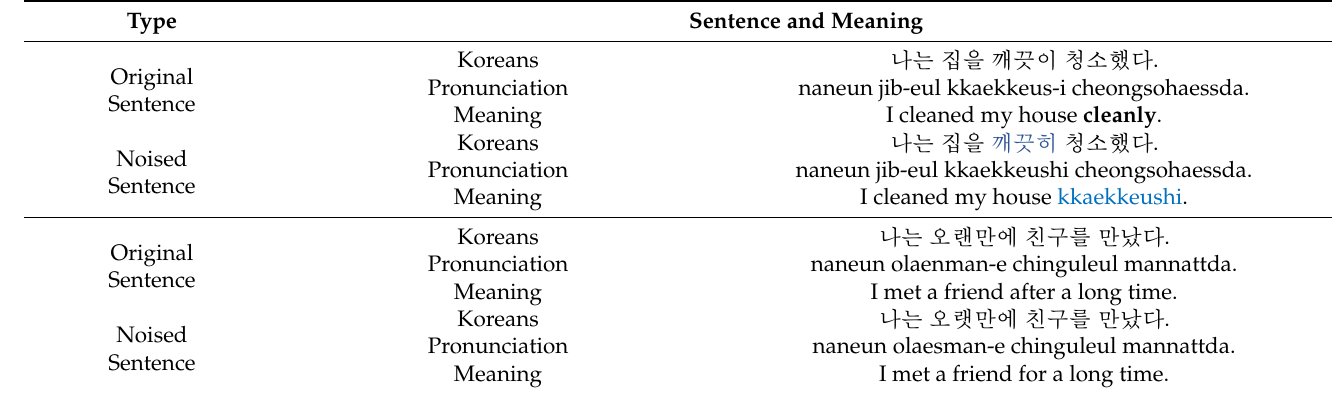
Table 3. Example of Heuristic-based Noising Rules.